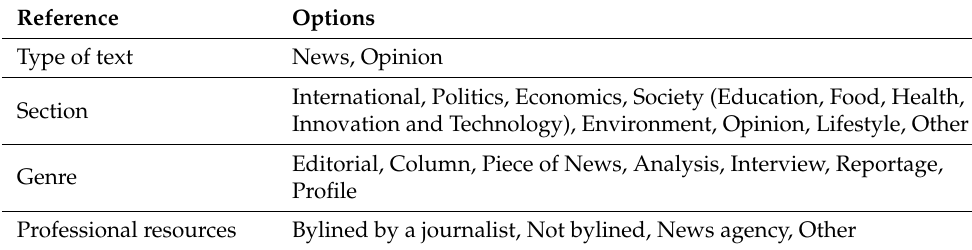
Table 1. Datasheet for quantitative analysis.